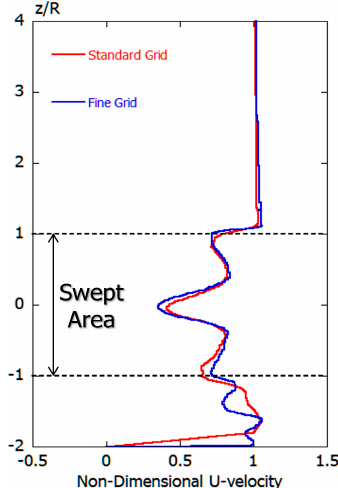
Figure A8. Comparison of vertical distribution of time-averaged U-velocity at x = 1.0 D in the case of uniform flow.